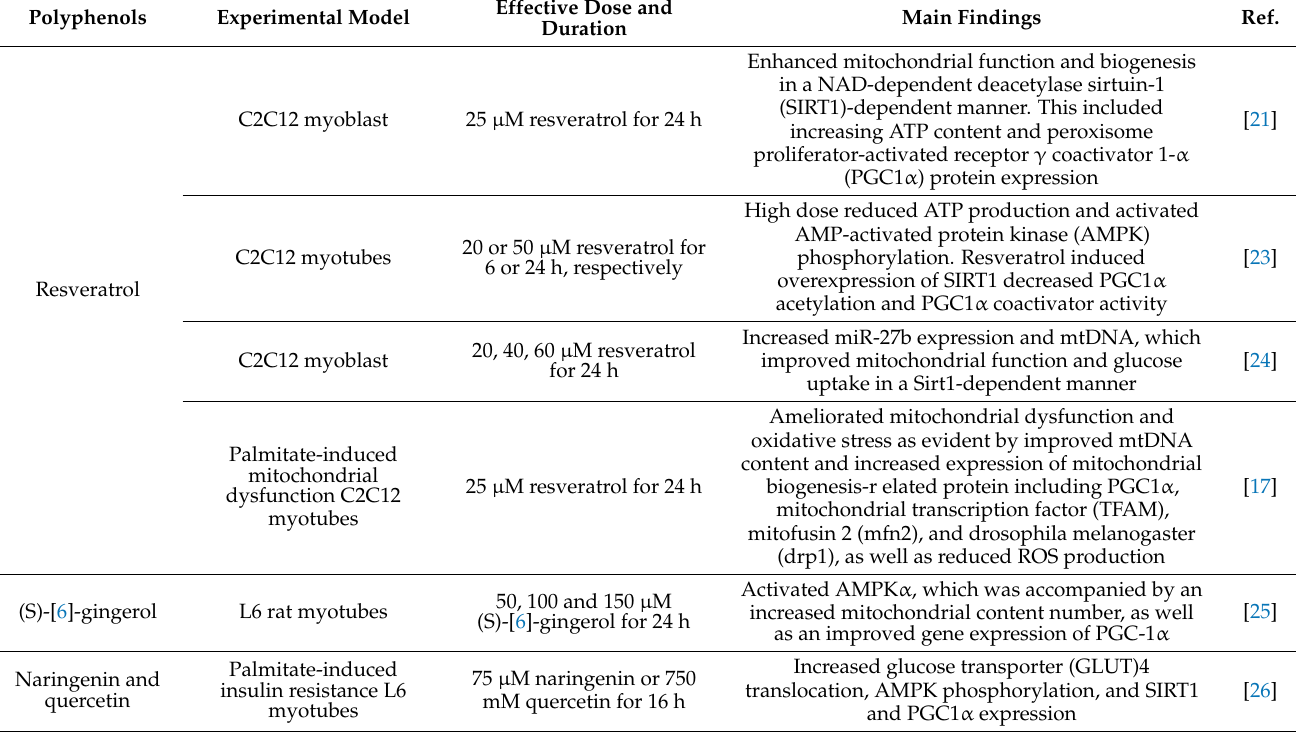
Table 1. A summary of the in vitro studies reporting on the impact of polyphenols on mitochondrial bioenergetics and metabolic function within the skeletal muscle.